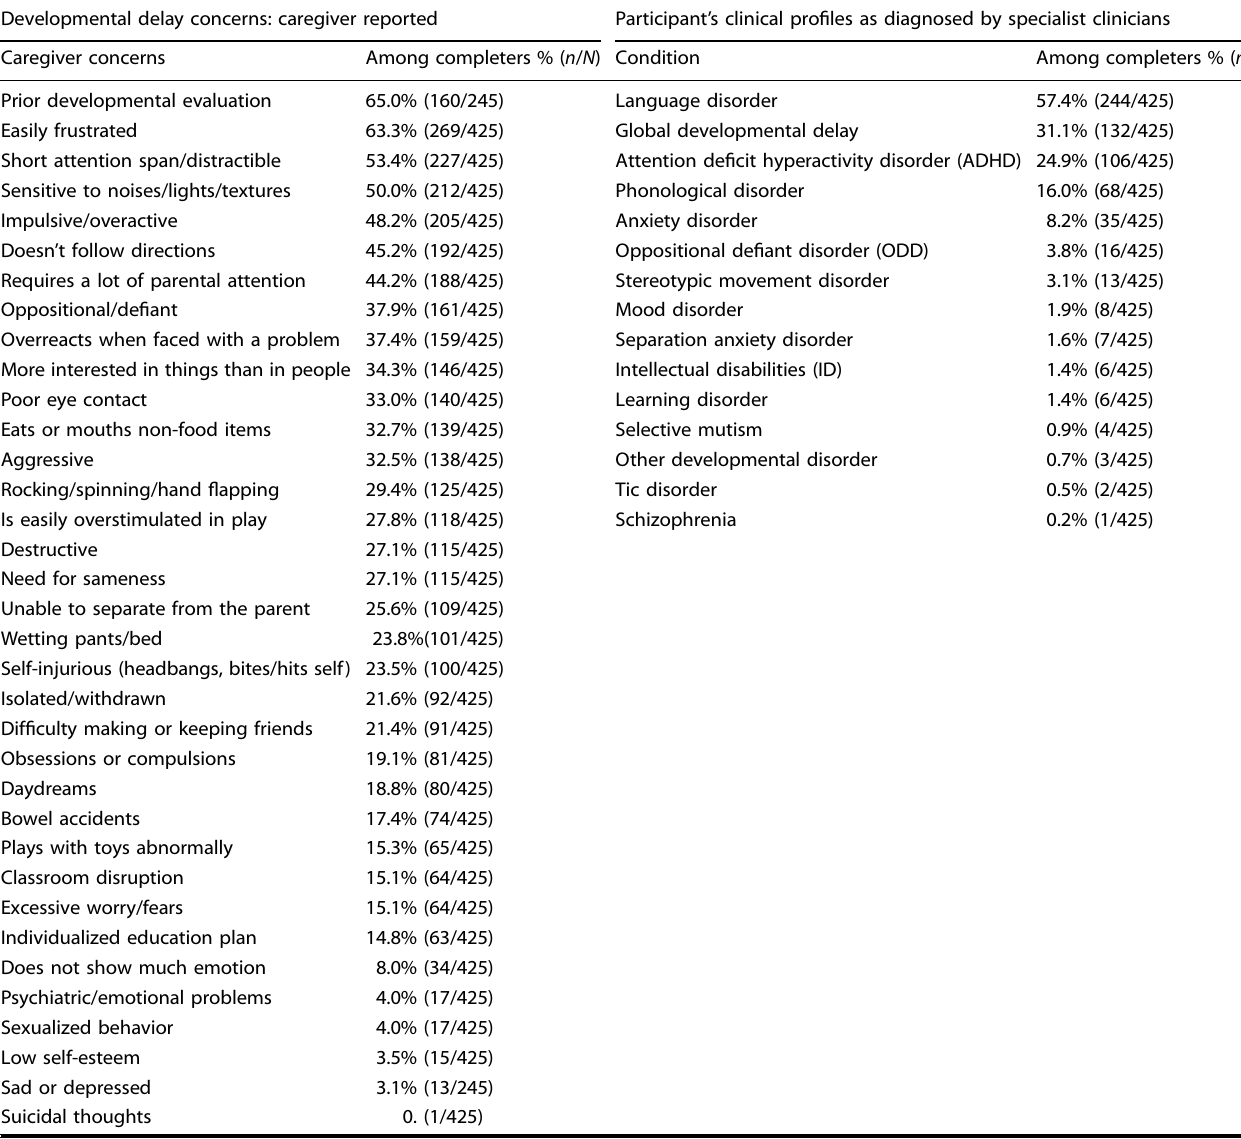
Table 2. Participant ’ s clinical pro fi les- caregiver and specialist